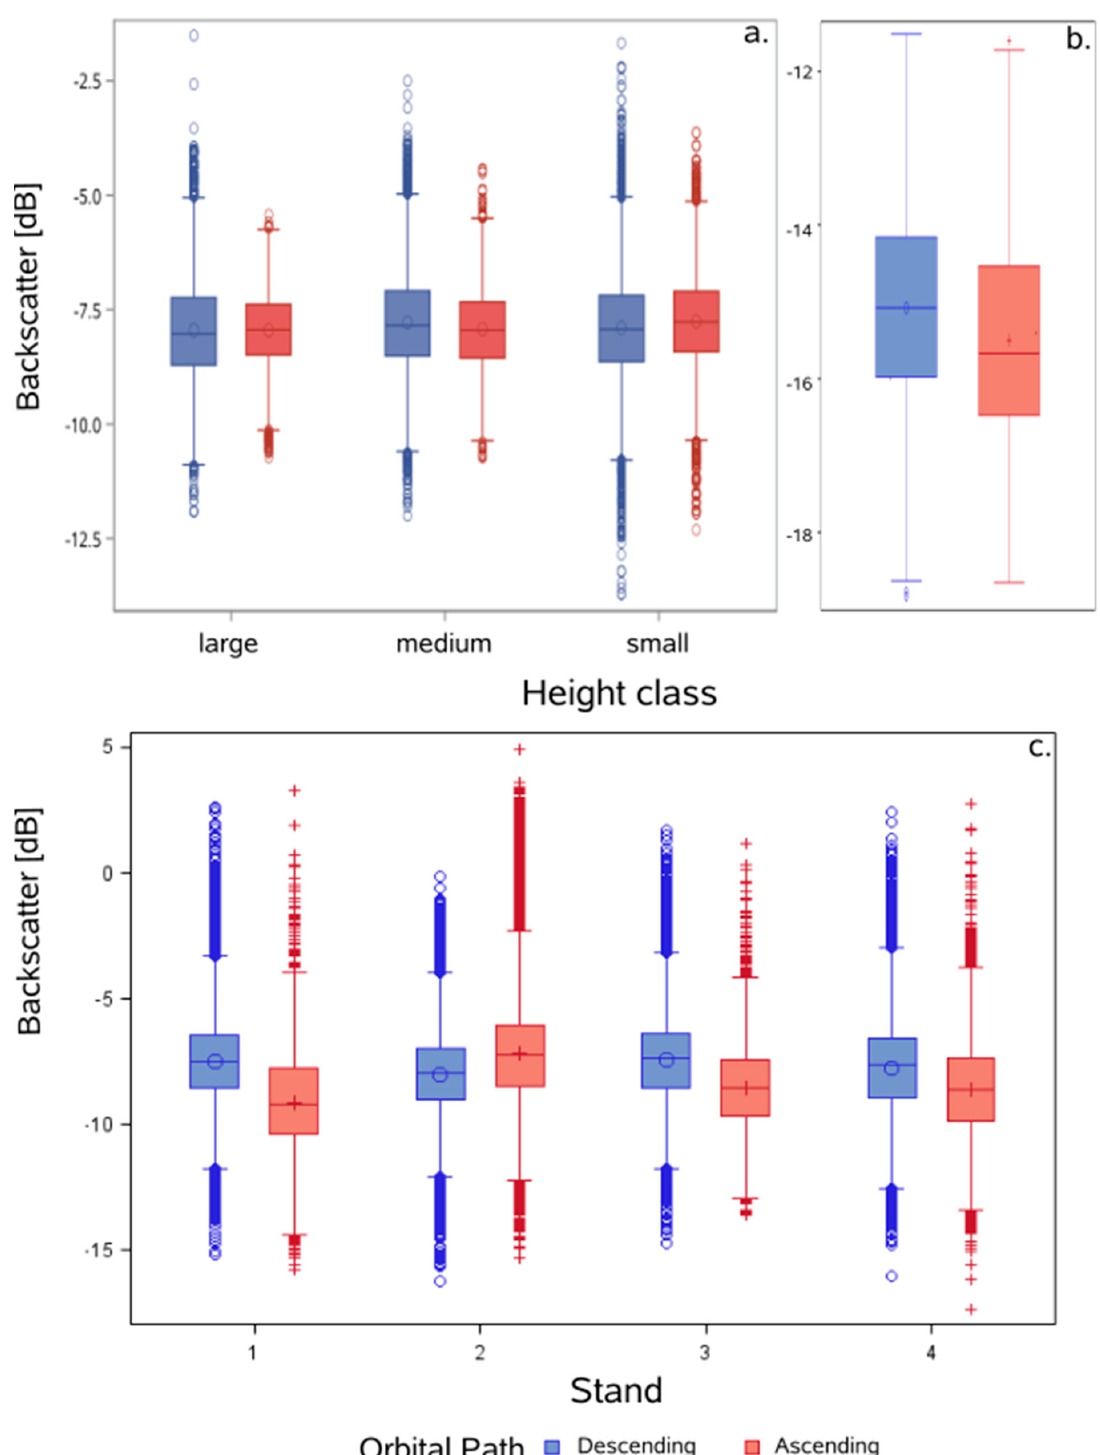
Figure 8. Comparison of ascending and descending orbits for: ( a ) three height classes within the study stands, ( b ) golf course, and ( c ) clear cut verification stands.